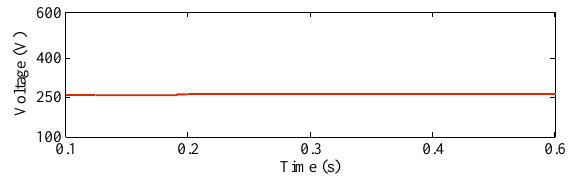
Figure 13. DC bus voltage under Mode II operation.